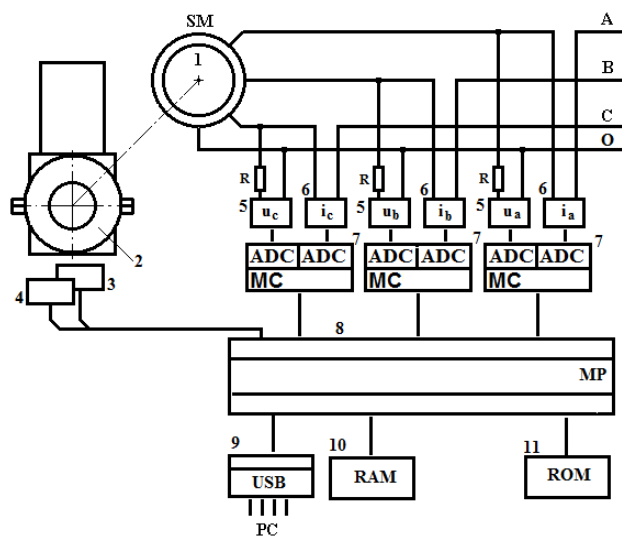
Fig. 5. Vvector diagrams of the synchronous machine.